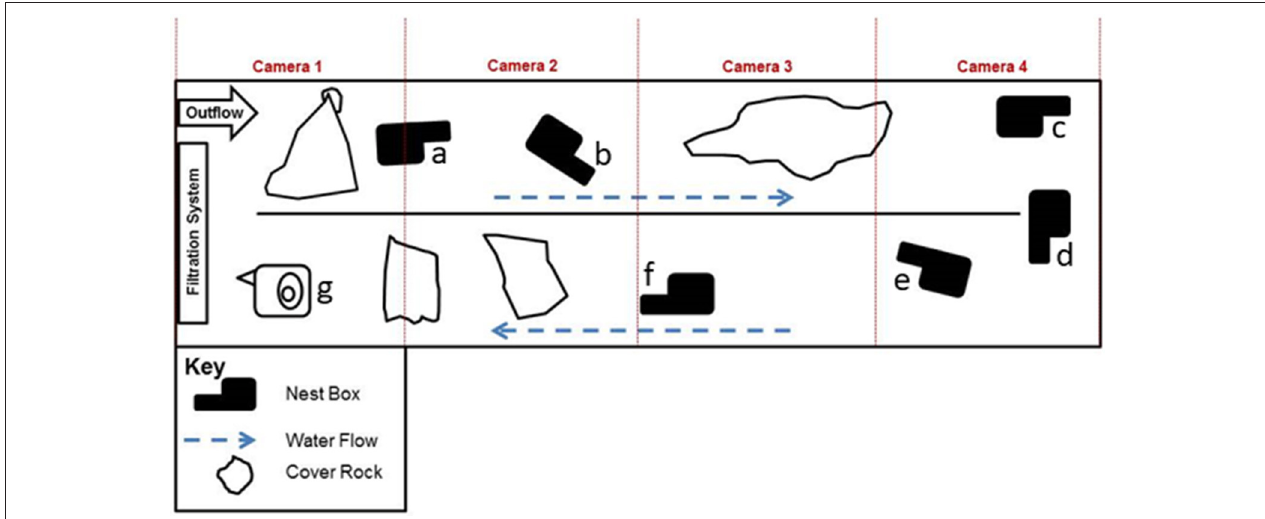
FIGURE 1 | Diagram of the artificial indoor stream (9.7m × 1.7m × 0.6m), including nest box (a–g) and cover rock locations, at the Saint Louis Zoo Herpetarium. For boot-shaped nest boxes (a–f) , the neck of the boot is the entrance chamber and the foot of the boot is the nest chamber. Nest box (g) is of an older, non-boot, design and was not used during any oviposition